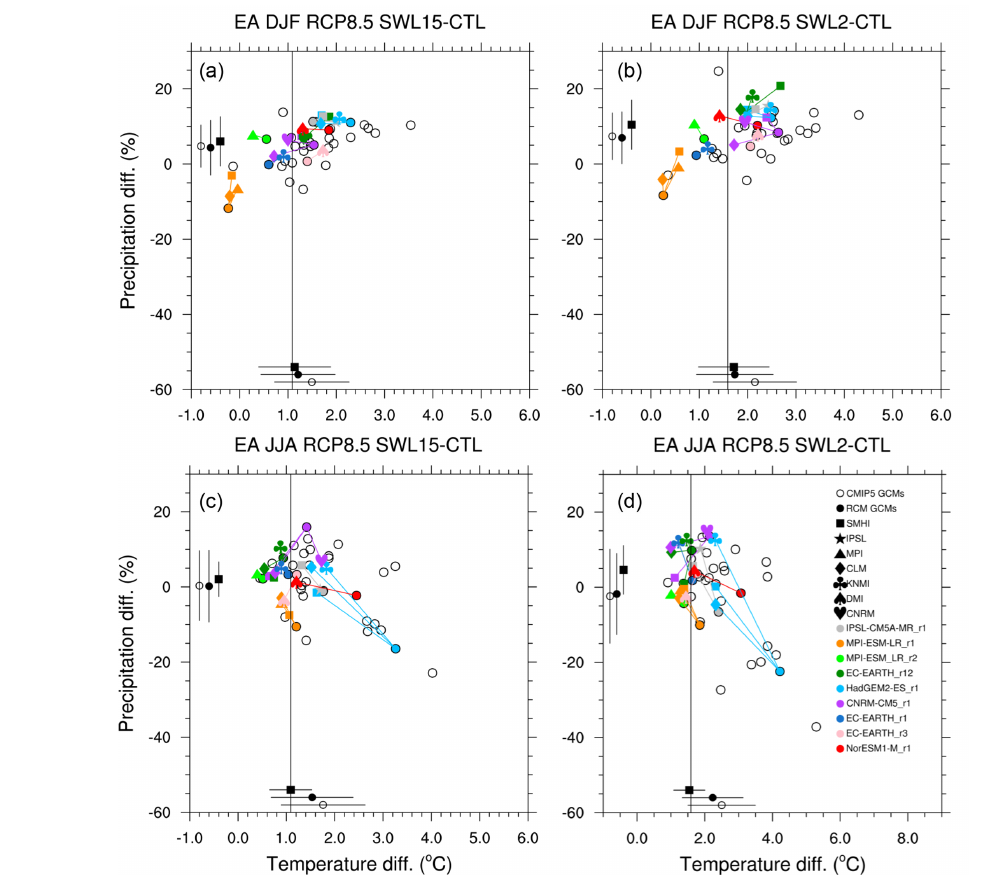
Figure 9. Temperature and precipitation changes over eastern Europe (EA, Fig. 1) for winter (a, b) and summer (c, d) mean conditions. Panels (a, c) show SWL1.5 and (b, d) SWL2. The error bars plotted inside the axis in the diagram illustrate the average and plus or minus 1 SD from (i) the CMIP5 ensemble (Table 2), (ii) the nine-member GCM ensemble that has been downscaled and (iii) the 18-member RCM ensemble (Table 1). Unfilled circles are CMIP5 GCMs listed in Table 2 that have not been downscaled. Filled circles represent GCMs that have been downscaled and these are connected by a line to the RCM(s) that have been used for downscaling. The vertical line represents the global mean warming at SWL1.5 and SWL2 relative to the control period